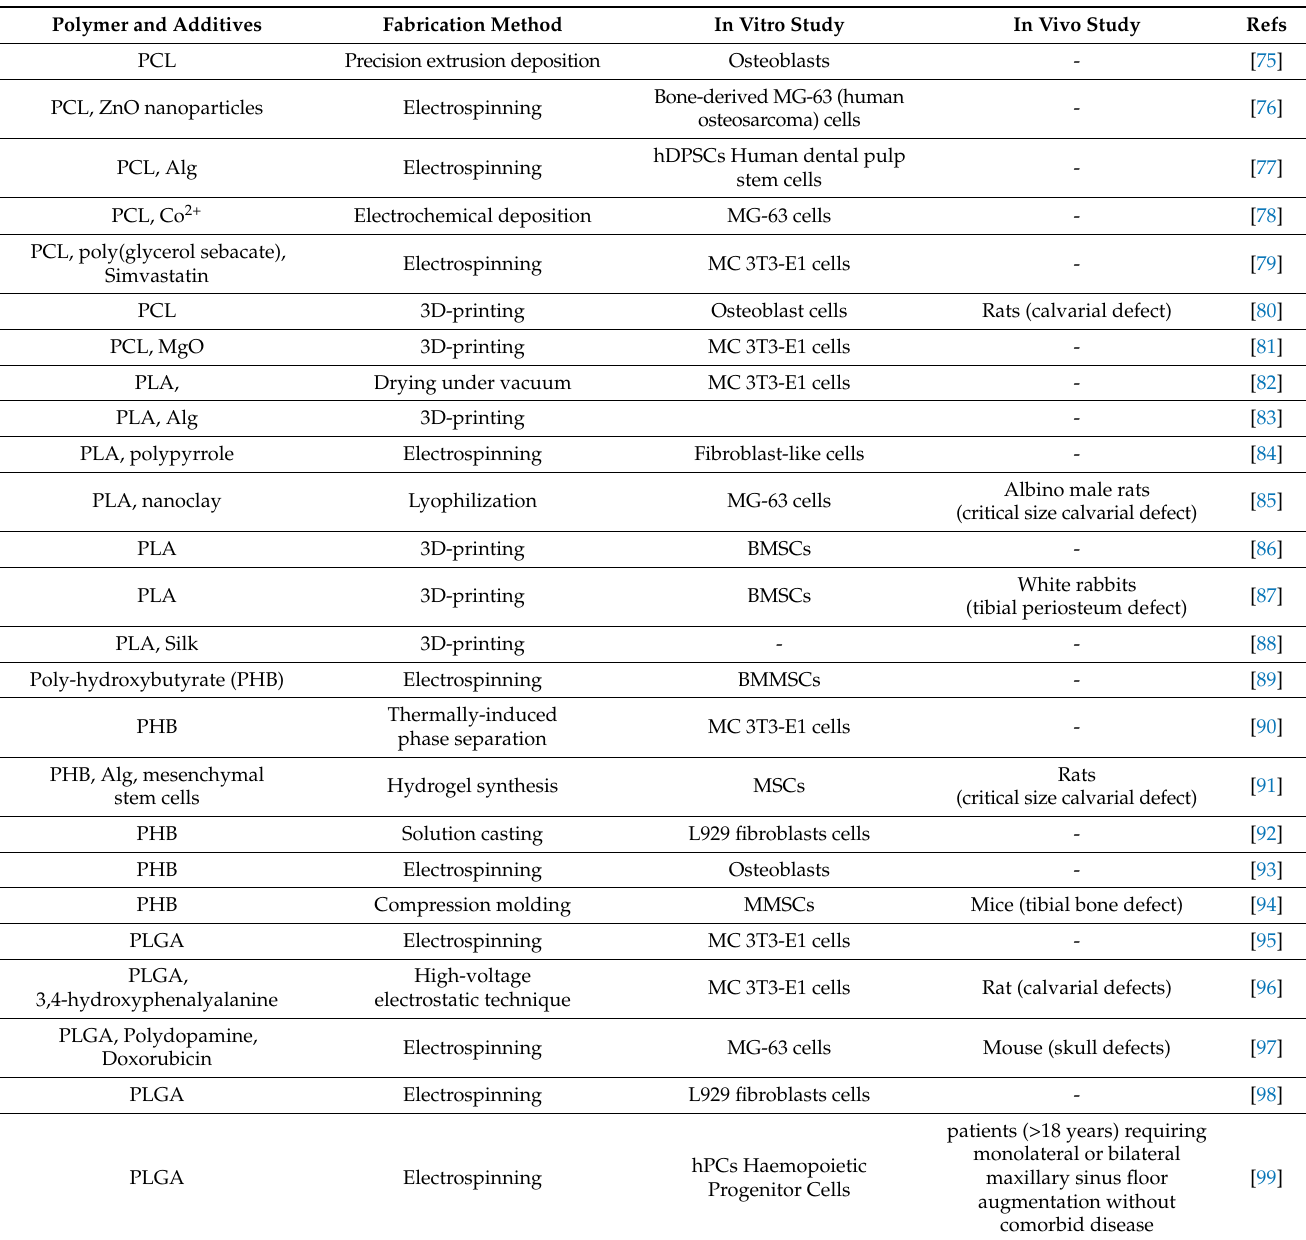
Table 3. Details of different synthetic polymers recently used in the preparation of hydroxyapatite biocomposite